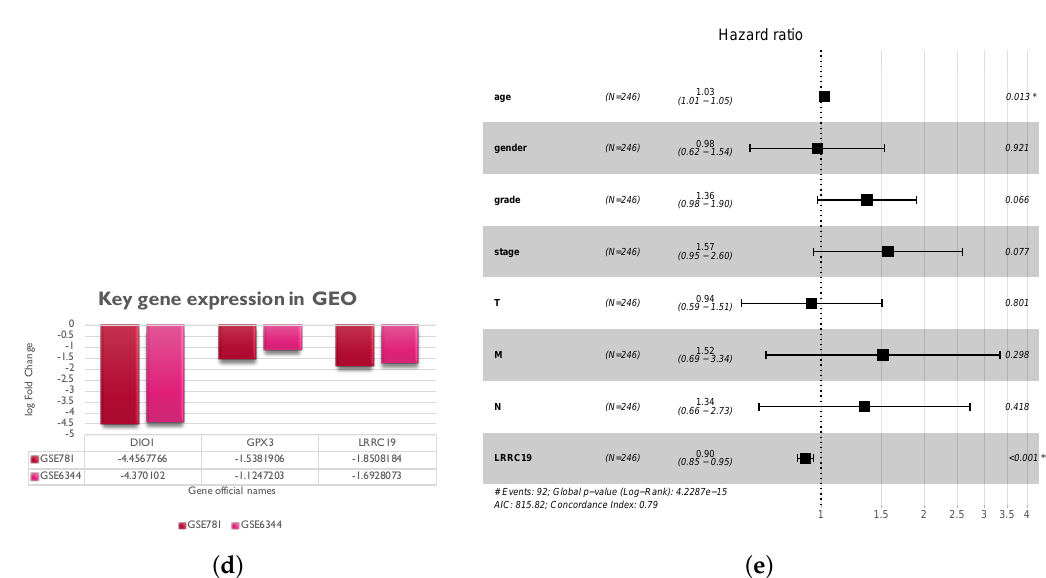
Figure 5. Screen and validation of intersection genes. ( a ) Validation of ACOX1, ALDH2, FUT6, and LRRC19 differential expression in KICR on GEPIA2. Box plots show that there was a significant FC | > 1 and p < 0.05). differential expression of LRRC19 between KIRC cases and normal cases (|log 2 ( b ) Stage plots of intersection genes expression with tumor stage in KICR on GEPIA2. Violin plots show ACOX1, FUT6, and LRRC19 were significantly downregulated in Stage IV ( p < 0.001). ( c ) Kaplan–Meier plots show the prognostic value of ACOX1, ALDH2, FUT6, and LRRC19. Overall and disease-free survival curves were generated for the comparison of survival percent between groups with high and low gene expression ( p < 0.01 in Log-rank test). ( d ) Validation of DIO1, GPX3, and LRRC19 expression fold change in independent GEO cohorts, GSE781 and GSE6344. ( e ) Multivariate analysis of the correlation of LRRC19 expression with OS among KIRC patients. The columns in the forest plot are parameter, number of patients, HR (IC 95%), and p value. (* p < 0.05, ** p < 0.01, *** p <